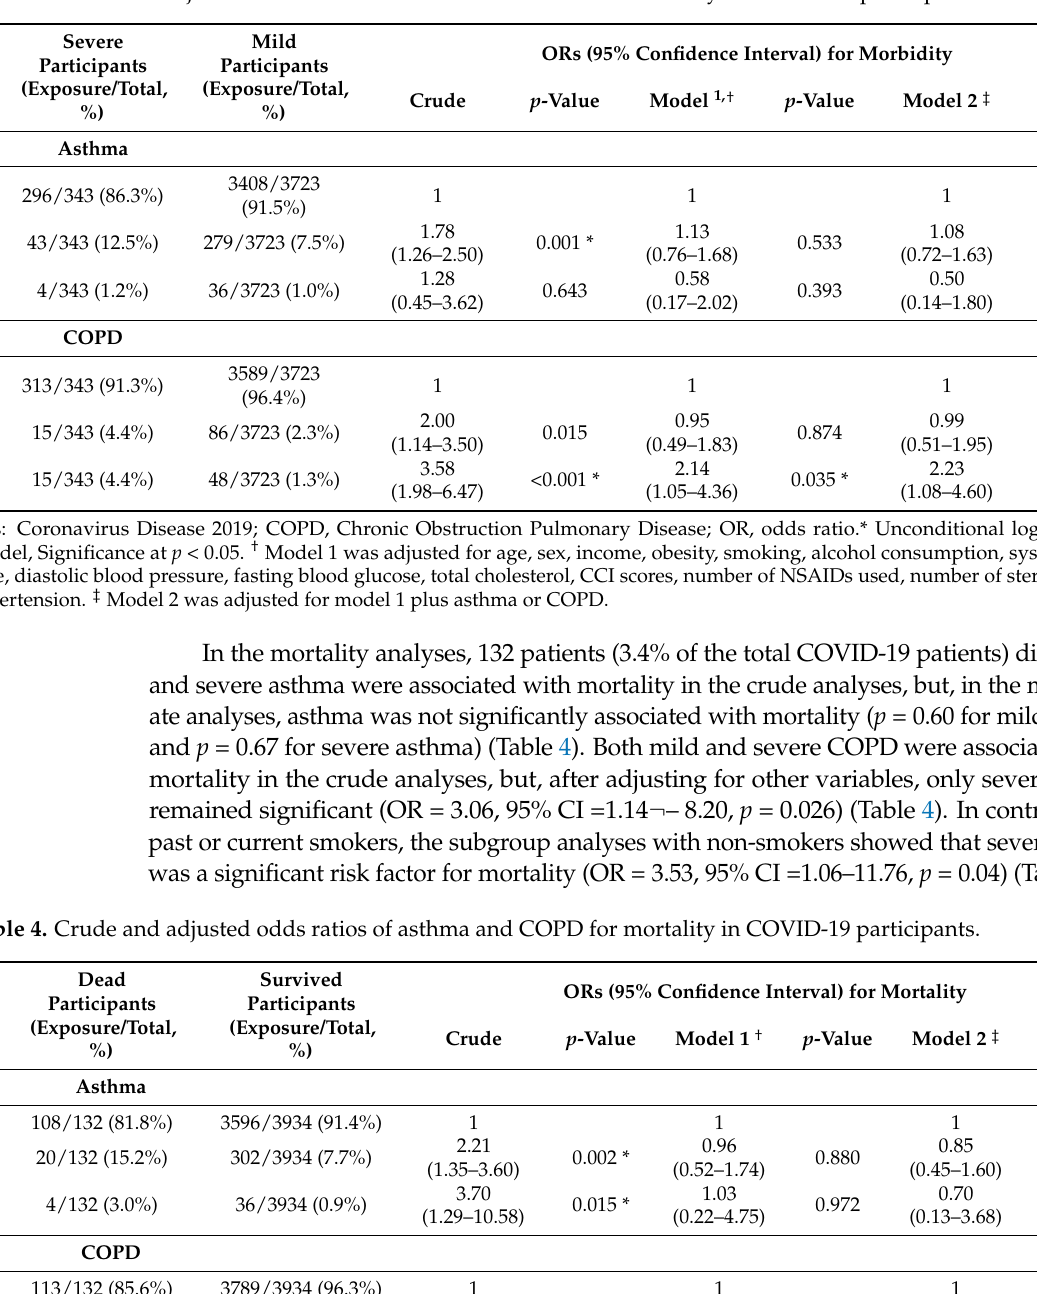
Table 3. Crude and adjusted odds ratios of asthma and COPD for morbidity in COVID-19 participants.